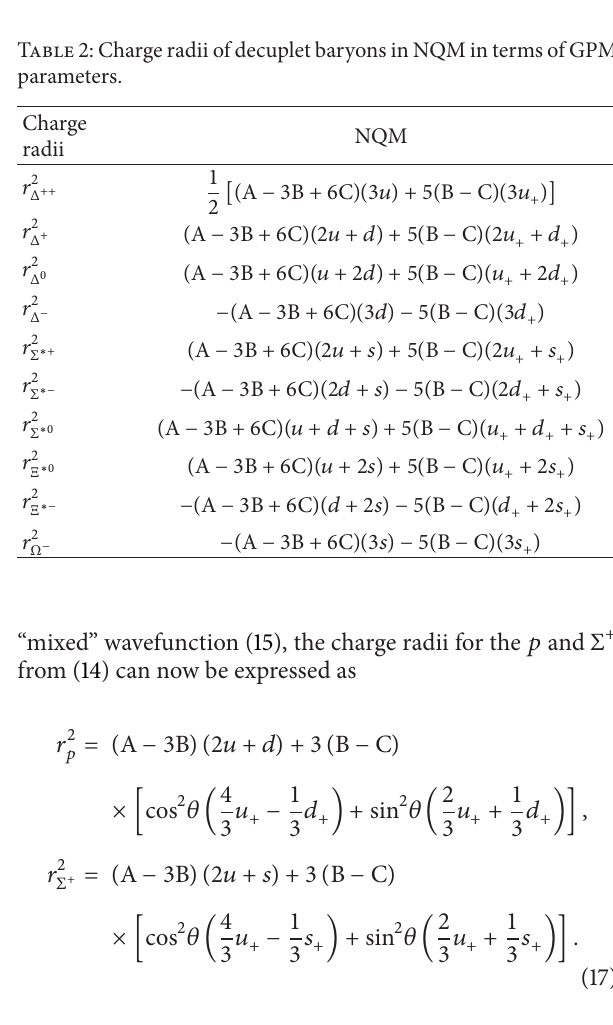
in terms of the GPM parameters. The results in NQM without configuration can easily config